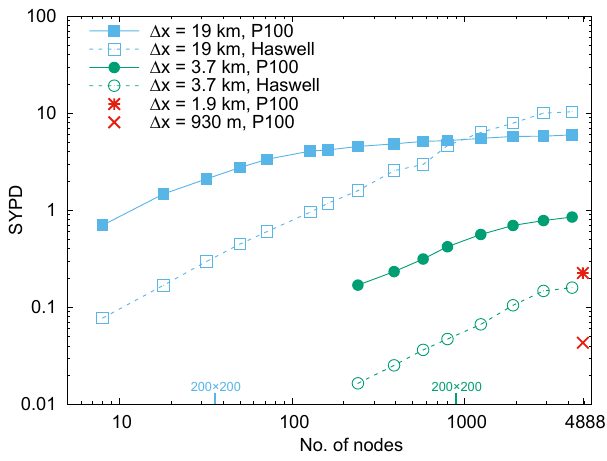
Figure 6. Strong scalability on Piz Daint: on P100GPUs (filled symbols) and on Haswell CPUs using 12MPI ranks per node (empty symbols).